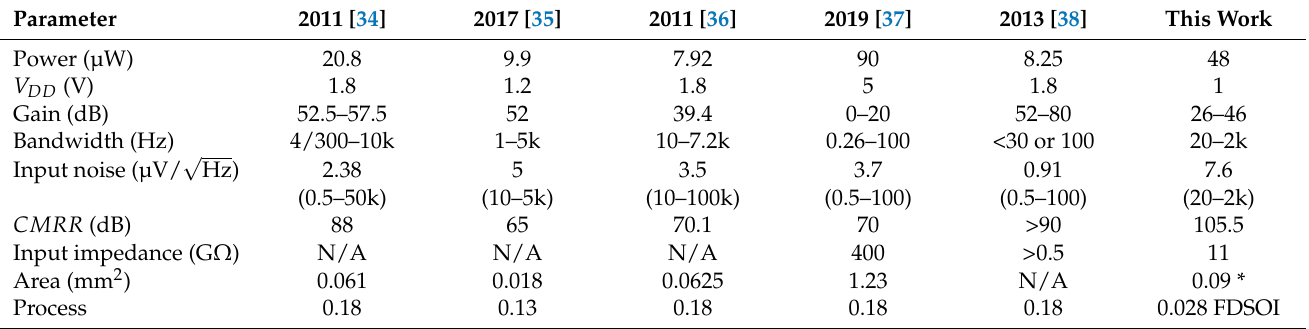
Table 2. Performance comparison